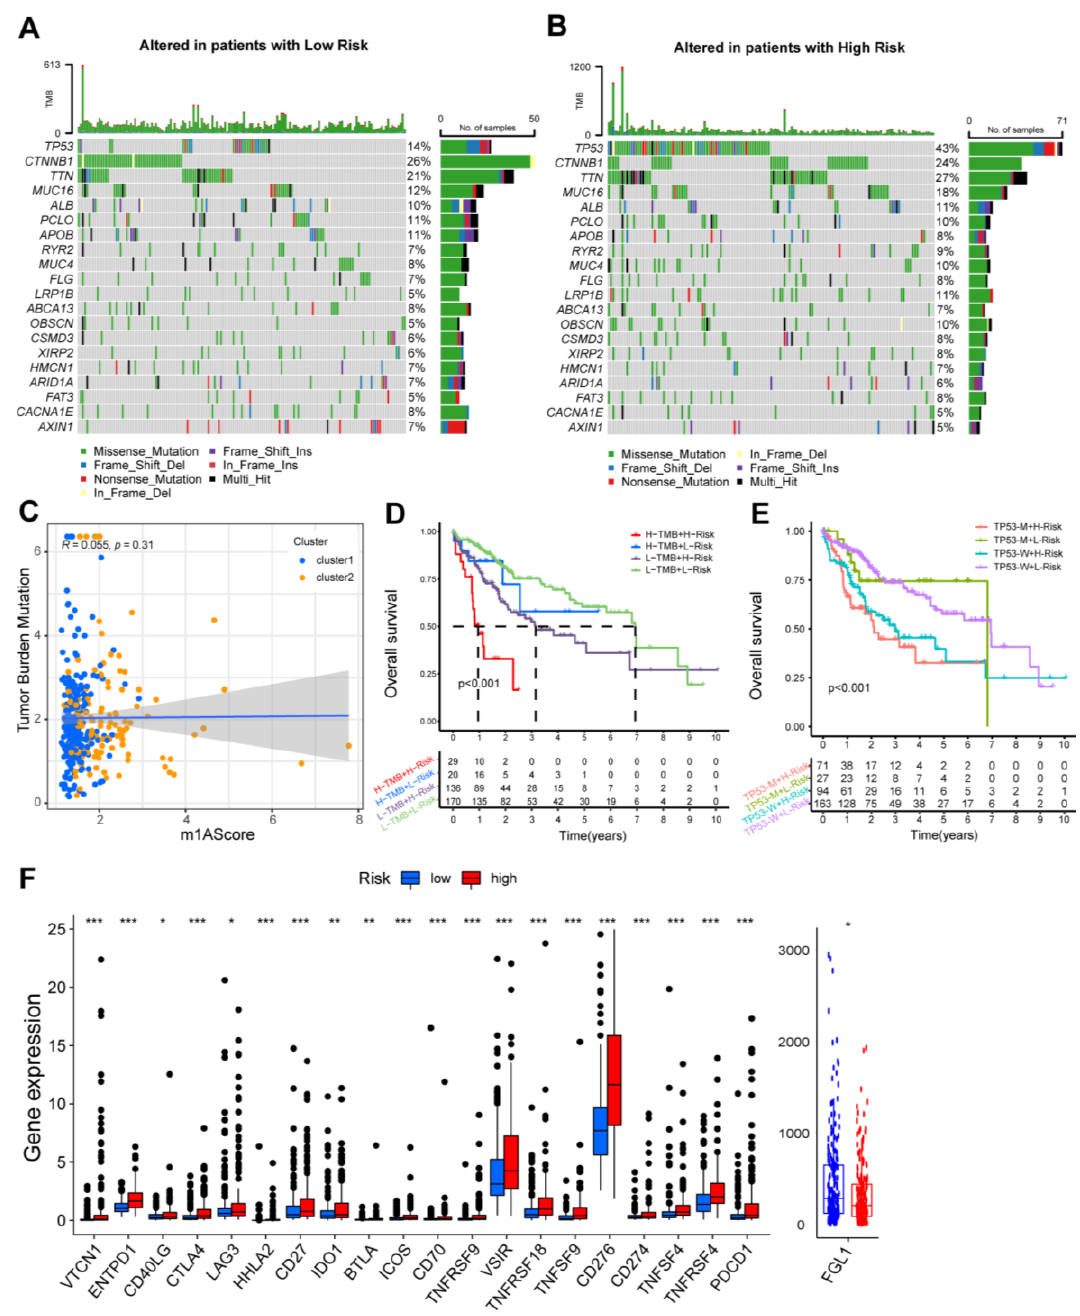
Figure 5. The prognostic impact of differential TMB scores or TP53 mutation status and immune landscapes between the high-risk and low-risk groups. ( A , B ) The top 20 driver genes with the highest mutational frequencies between the high-risk group and low-risk group. ( C ) Correlation analysis between the TMB and m1AScore. ( D ) Kaplan–Meier curves of OS for HCC patients with different TMB scores and the prognostic signature. ( E ) Kaplan–Meier curves of OS for HCC patients with different TP53 status and the prognostic signature. ( F ) Differential expression analysis of various immune checkpoint genes between the high-risk and low-risk groups. Tumor mutational burden, TMB; Overall survival, OS; Hepatocellular carcinoma, HCC. *, p < 0.05, **, p < 0.01; ***. p <